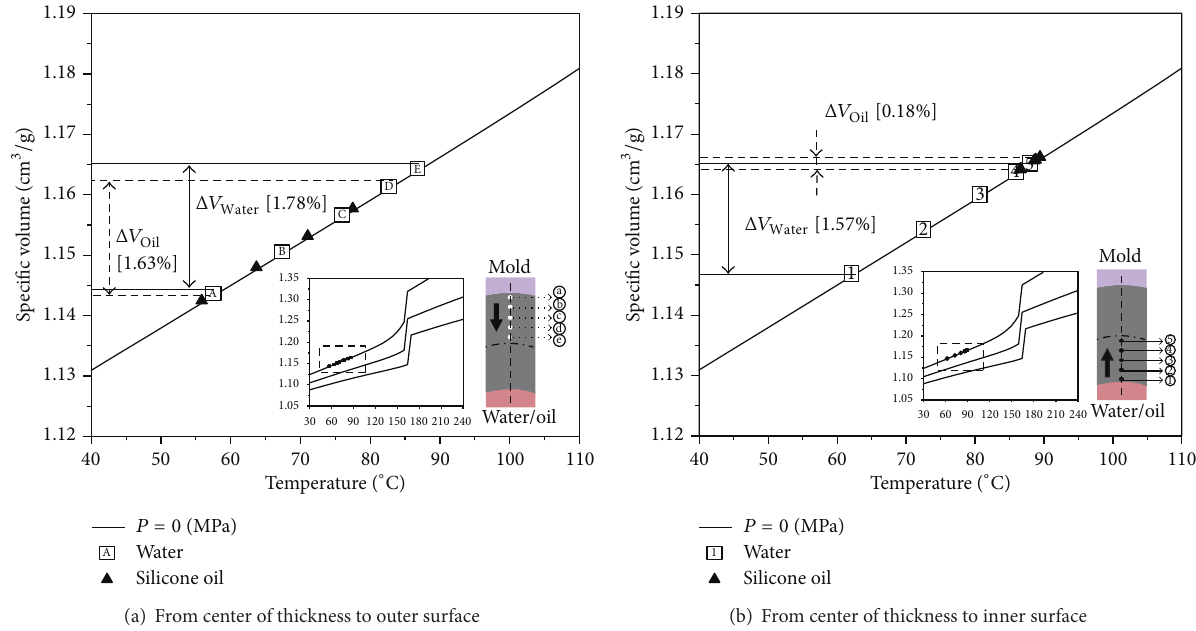
Figure 9: Temperature versus specific volume for hollow part thickness.